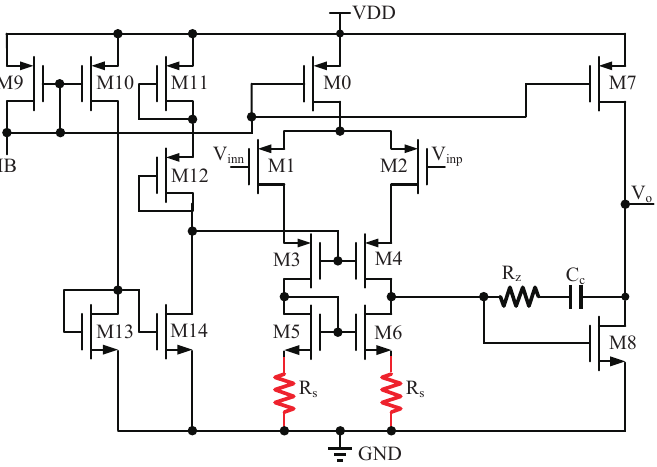
Figure 8. Circuit diagram of the operational transconductance amplifier (OTA1 and